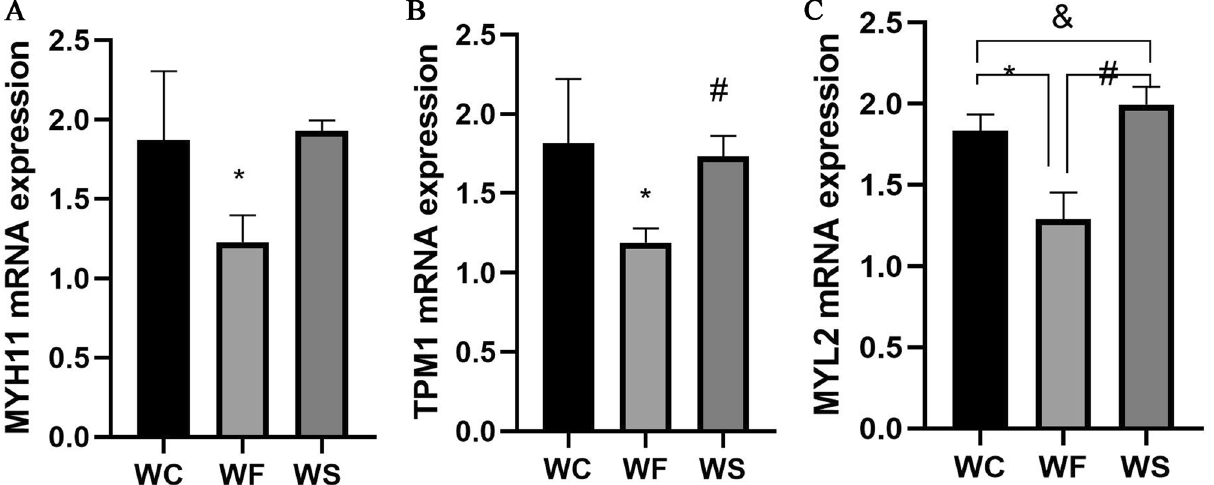
Figure. 8. Reverse transcription-quantitative PCR validation of myosin heavy chain 11 (MYH11), tropomyosin 1 (TPM1) and myosin light chain 2 (MYL2) in adipose tissue samples of WC, WF and WS groups. (A) The mRNA expression of MYH11 in the group of WC, WF and WS; (B) the mRNA expression of TPM1 in the group of WC, WF and WS; (C) the mRNA expression of MYL2 in the group of WC, WF and WS. *P < 0.05 WF